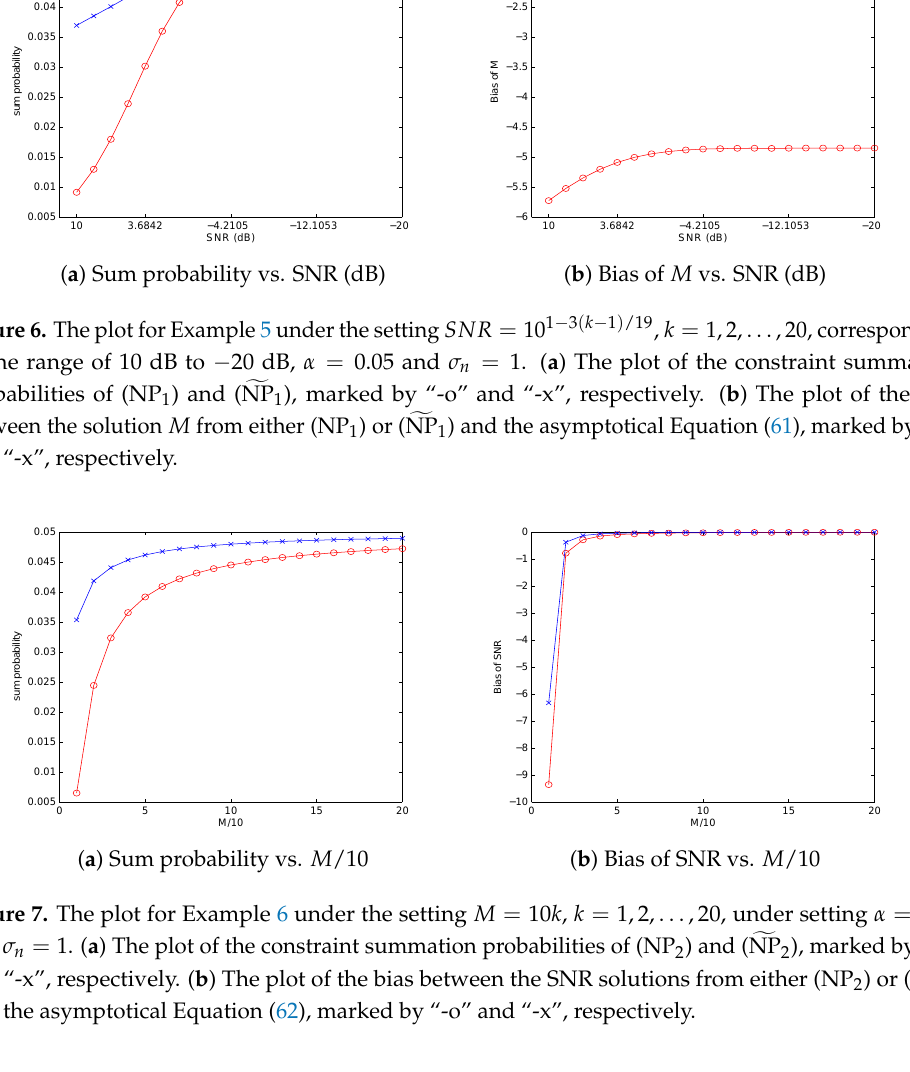
NP 2 ), marked by “-o” NP 2 ) (cid:102) (cid:102)